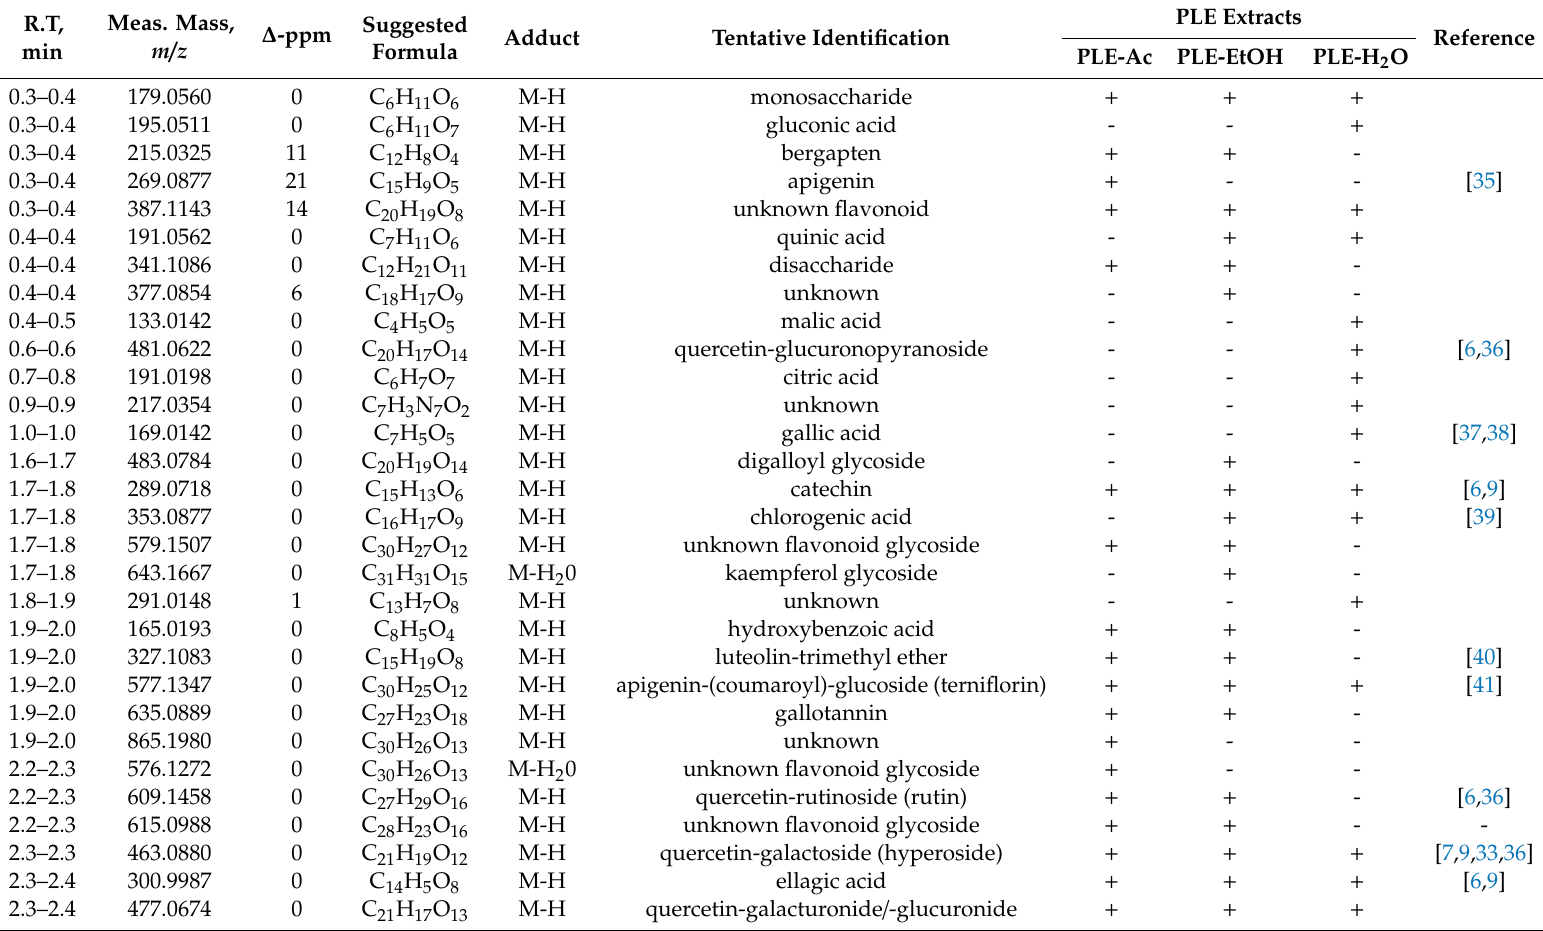
Table 5. Qualitative phytochemical characterization of D. fruticosa leaves semi-polar and polar extracts after sequential pressurized liquid extraction (PLE) with acetone, ethanol, and